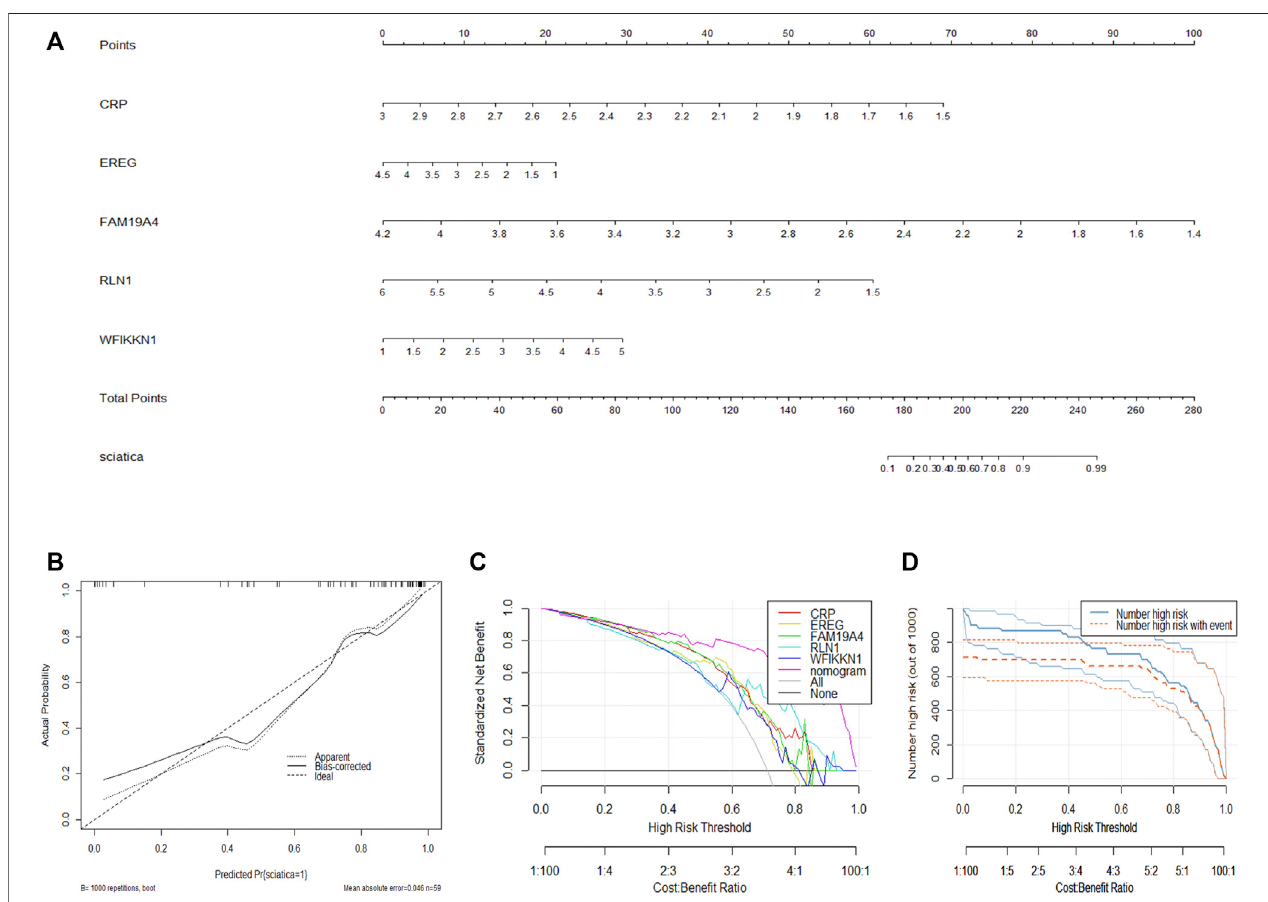
FIGURE 4 | Construction ofthe nomogram model. (A) Construction ofthe nomogram model based on the selected DEIRGs (RLN1, EREG, FAM19A4, WFIKKN1, and CRP). (B) Calibrationcurveshowingthediagnostic power ofthenomogram model. (C) DCAshowingthatthenomogram model hashigherclinicalapplicationvalue than individual DEIRGs. (D) Clinical impact curve showing that the diagnostic power of the nomogram model is relatively high.